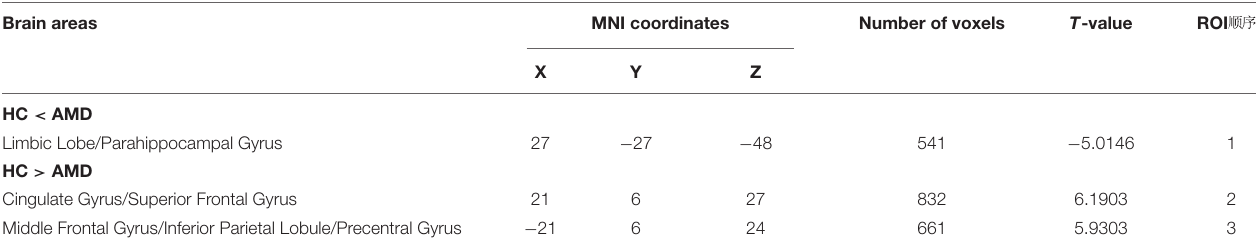
TABLE 2 | Brain regions with significantly different ReHo values between the AMDs and HCs. Brain